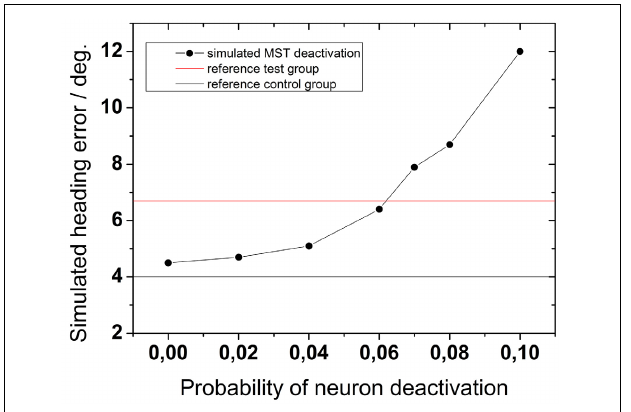
FIGURE 10 | Network simulation: the effect of aging on heading performance. The solid horizontal lines represent as a reference the experimental results from both subject groups as obtained for 100 dots and 2000ms (solid black line: test group; solid red line: control group). Black symbols represent simulated heading errors as function of different